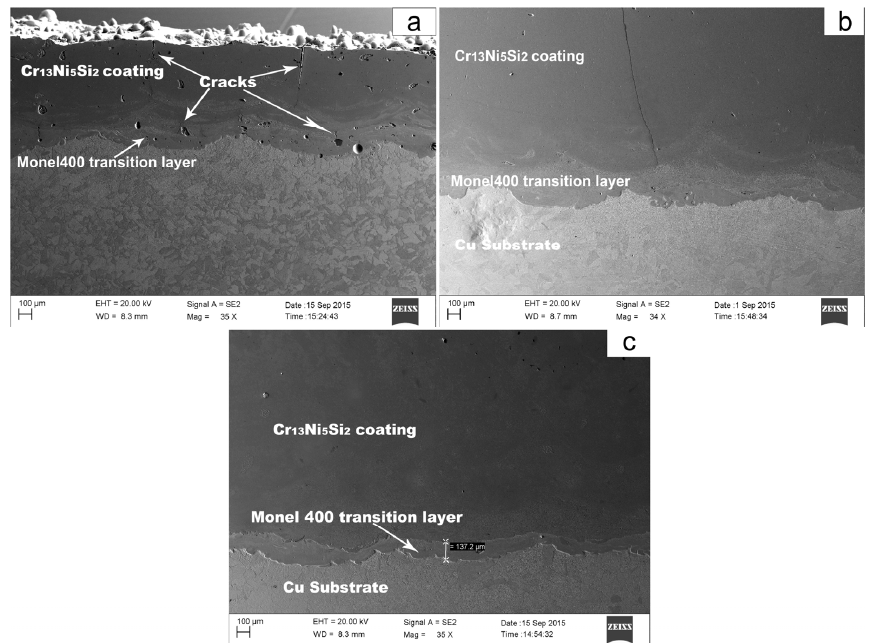
Figure 3. Scanning electron microscope (SEM) images of cross-section crack patterns of coatings deposited using ( a ) pulse laser cladding (PLC); ( b ) pulse laser induction cladding (PLIC) at 600 °C and ( c ) PLIC at 750 °C.